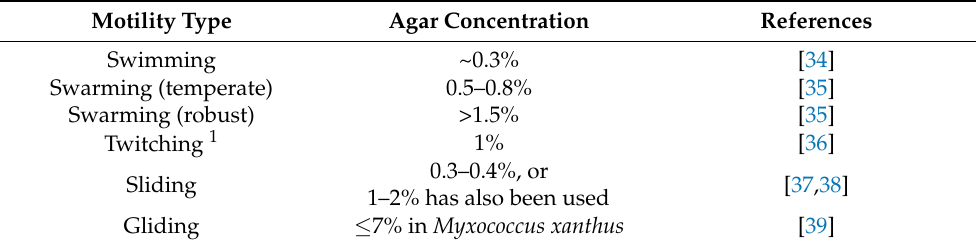
Table 2. Agar concentration in media according to the type of motility type to assess in a semi-solid (soft) agar